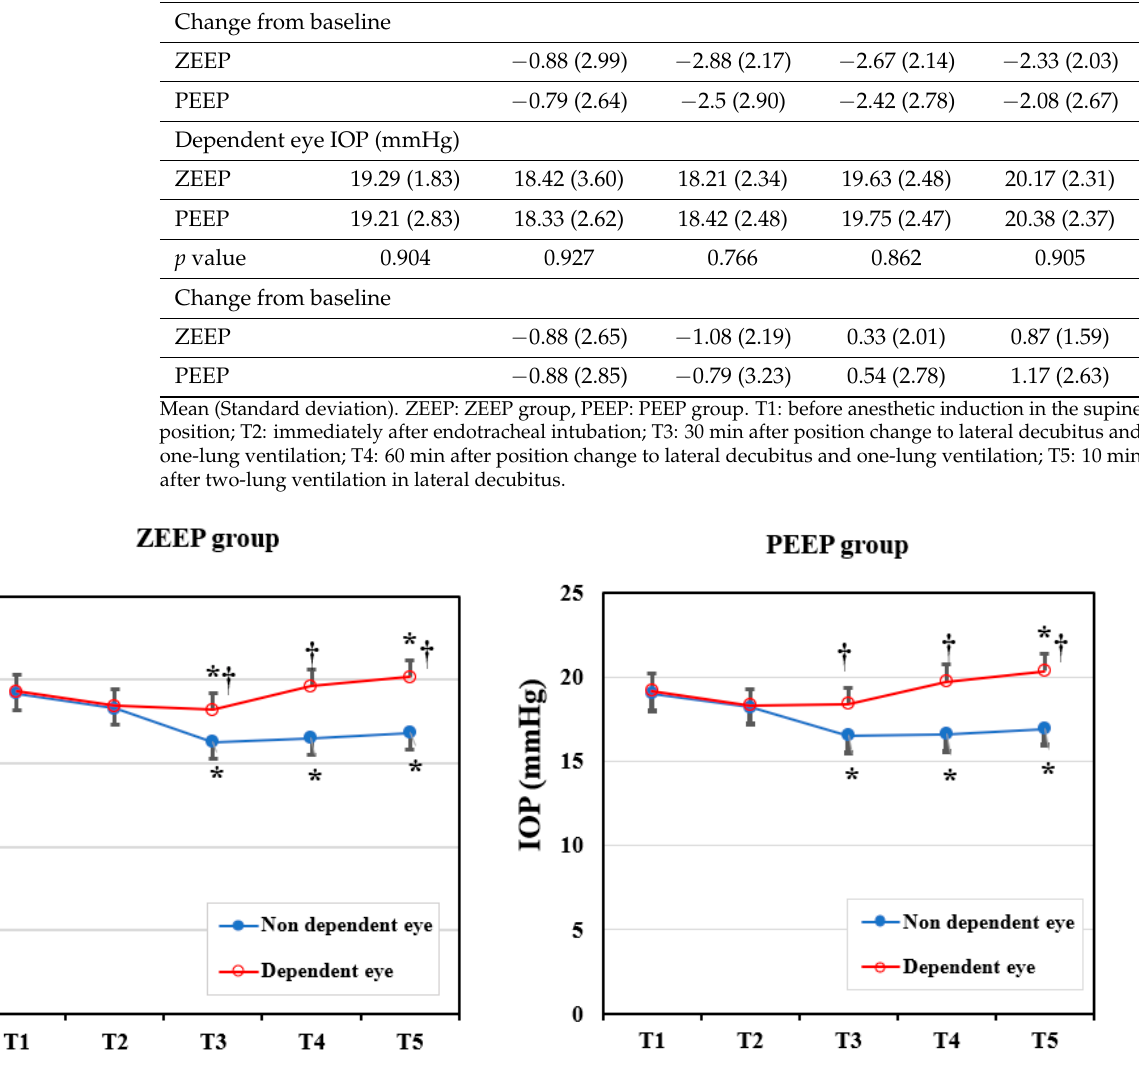
Figure 2. Changes in the intraocular pressure (IOP) in the ZEEP and PEEP groups (dependent eye vs. non-dependent eye). T1: before anesthetic induction in the supine position; T2: immediately after endotracheal intubation; T3: 30 min after position change to lateral decubitus and one-lung ventilation; T4: 60 min after position change to lateral decubitus and one-lung ventilation; T5: 10 min after two-lung ventilation in the LDP (near completion of surgery). * p < 0.05 compared with baseline (T1) value in the same eye. † p < 0.05 compared with the non-dependent eye.